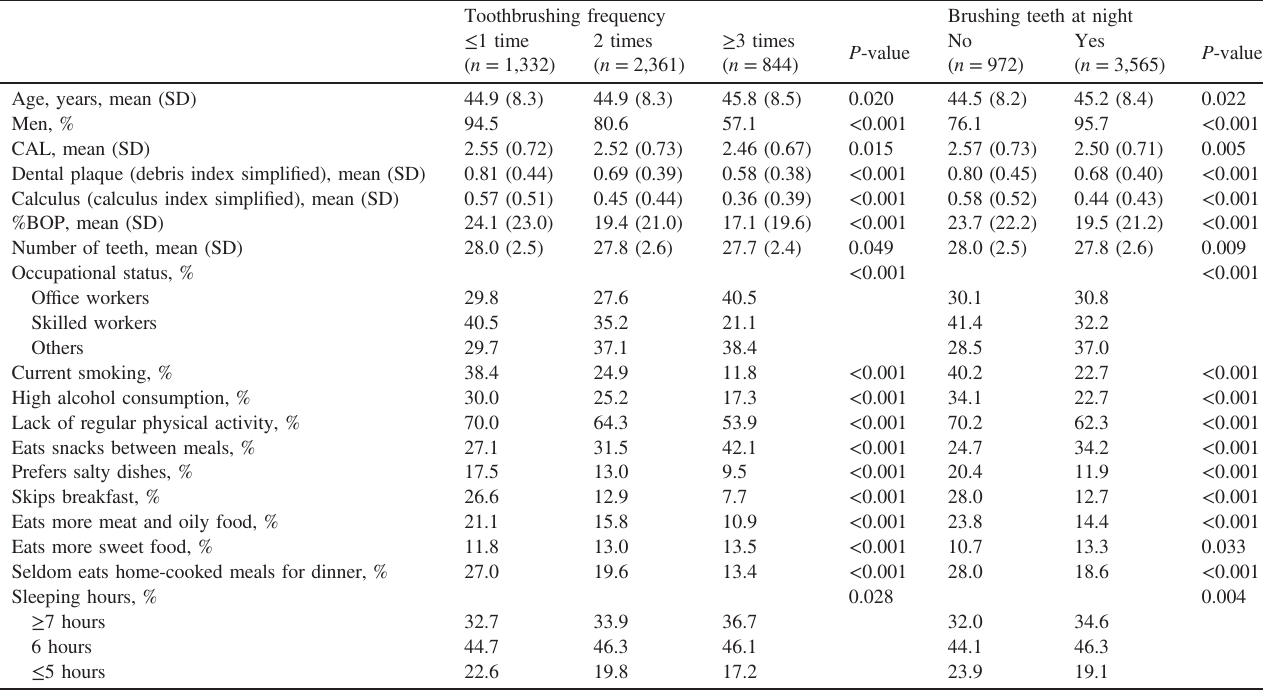
Table 3. Oral condition and lifestyle factors according to toothbrushing habits at baseline Toothbrushing